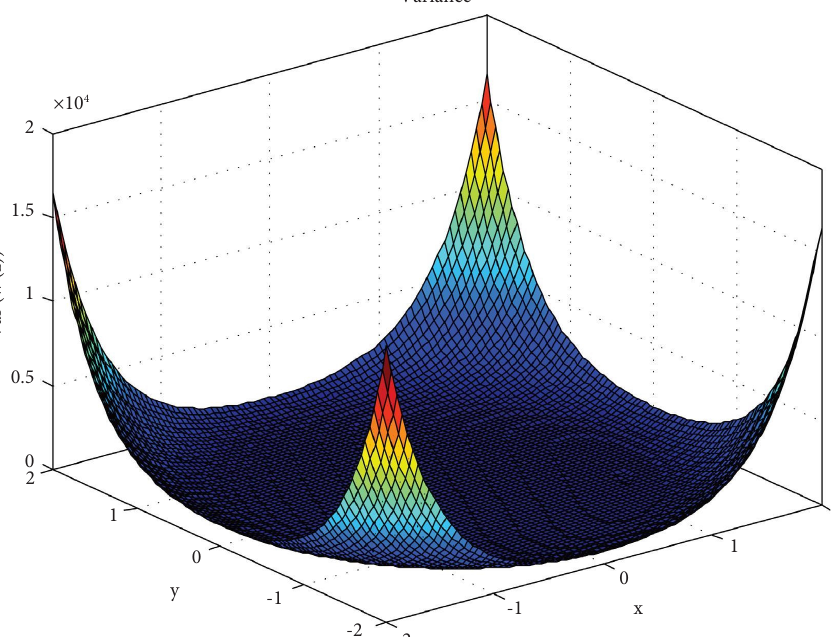
Figure 5: Variance of equation (29) for μ � 1 , σ �